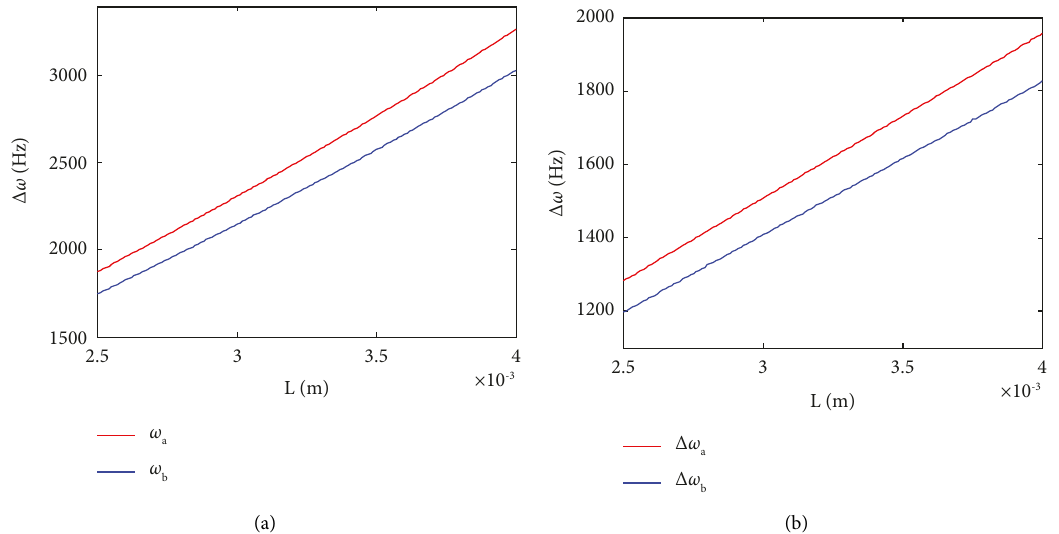
Figure 5: Effects of the nonlinear parameter on resonant frequency difference. (a) Odd. (b) Even.